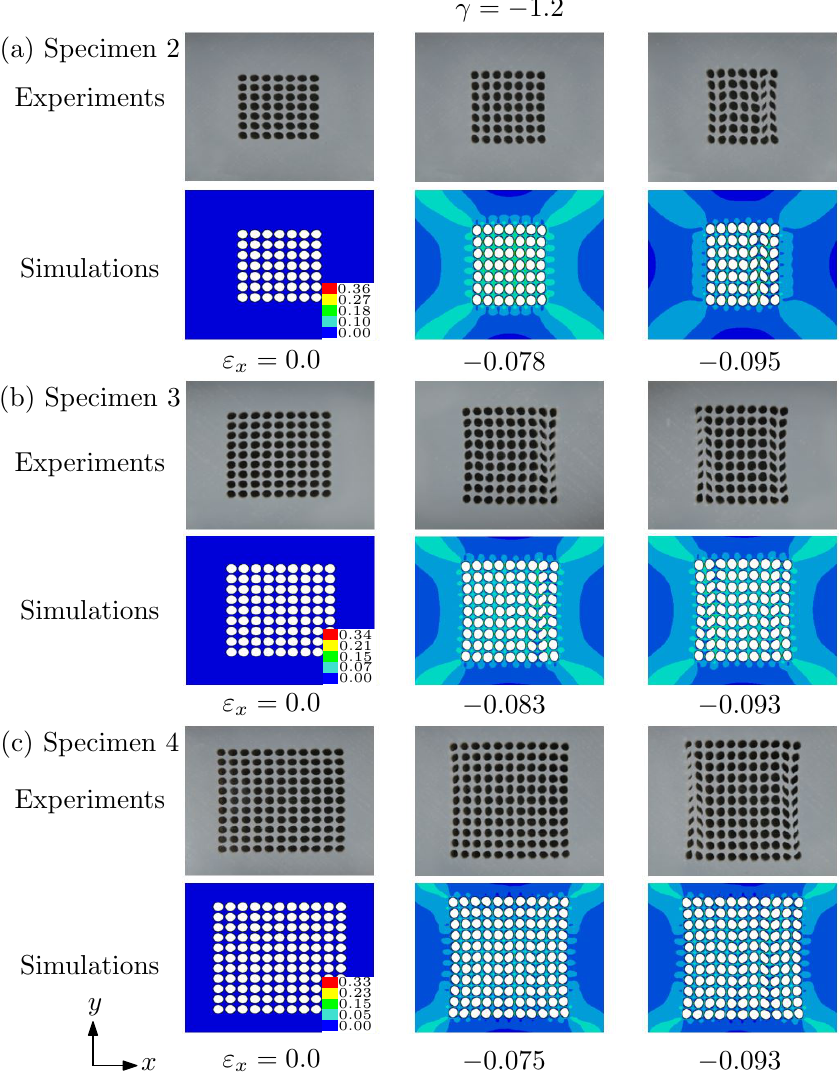
Figure 9. Deformed morphologies at different applied strains predicted by the simulations and the experiments. ( a ) Specimen 2; ( b ) specimen 3; ( c ) specimen 4. Under this biaxiality ratio γ = only pattern transformation II (chevron voids) could be observed. The color bar shows the effective strain of the